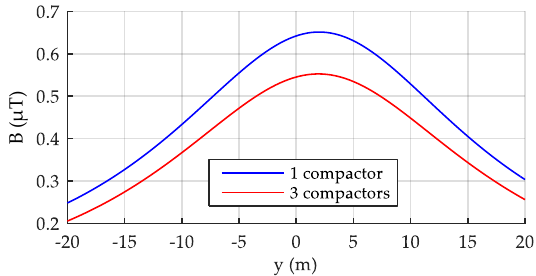
Figure 10. Distribution of the magnetic induction B , evaluated at the center of the span along a direction orthogonal to the overhead line, 1 m above the ground level. Comparison between cases with one and with three compactors.